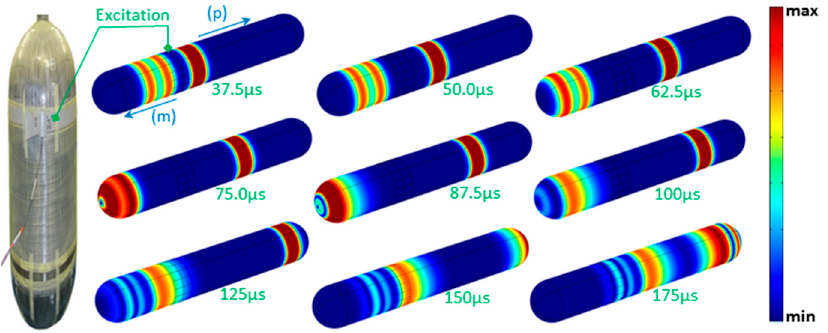
Figure 11. Photography of a vessel equipped with a circumferential actuator ( left ); and wave-field evolution for the like-T(0,1) mode, at different propagation time-steps ( right ). The signs (m) and (p) indicate negative and positive propagation directions,